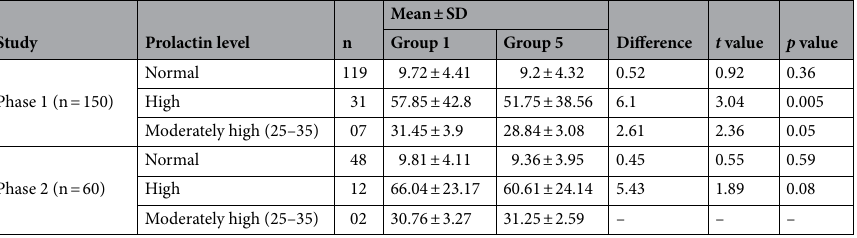
Table 4. Results and statistical comparison of the normal and high results of both Phase 1 and Phase 2 study.